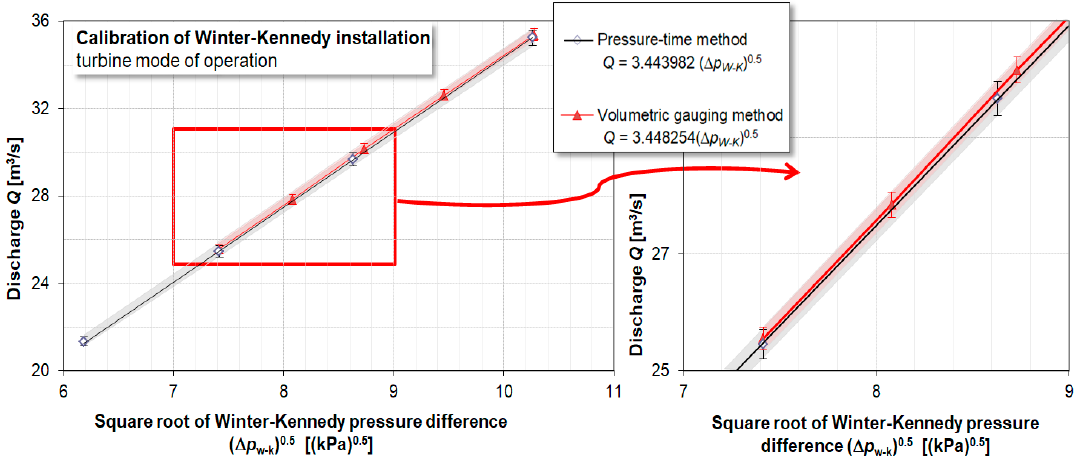
Figure 10. Turbine operation mode of the tested hydrounit: Comparison of the volumetric measurement method and the pressure-time method based on the results of calibration of the technical installation of the Winter–Kennedy method, with which the tested pump-turbine was equipped.